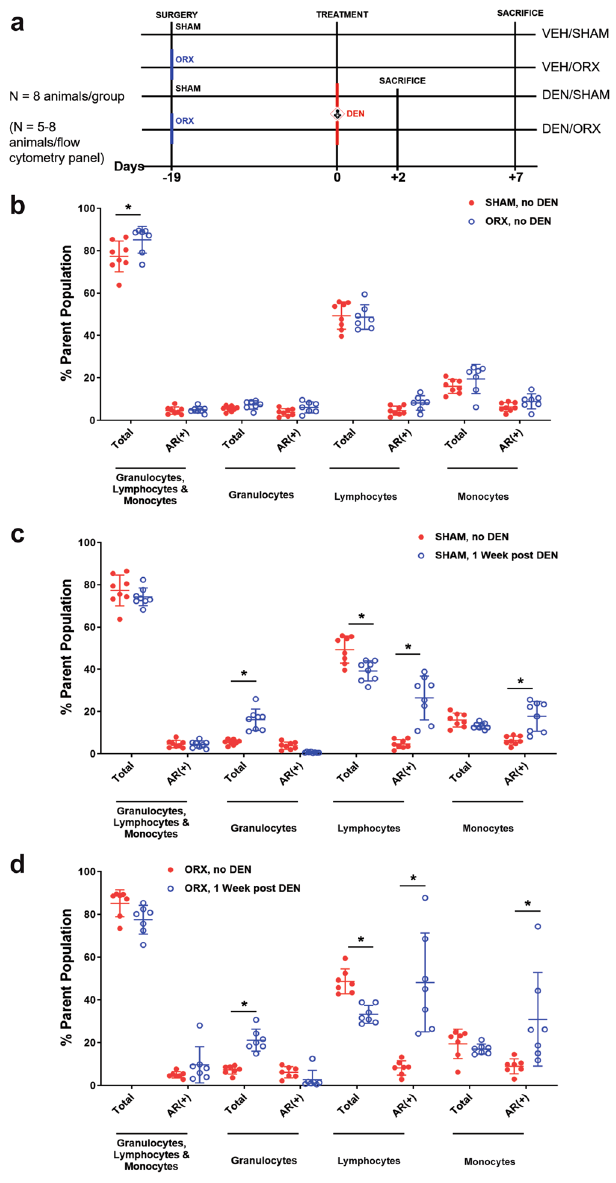
Figure 4. DEN increases proportion of AR+ lymphocytes and monocytes in SHAM and ORX. Liver immune cell populations were analyzed by flow cytometry as described in Materials and Methods and represented as percent of parent population and pre-gated on CD45+ and living cells. Positive cells were defined by fluorescence minus one (FMO) controls (See Supplementary Fig. S4 online for gating strategy). ( a ) Simplified experimental timeline. Surgery was performed on 8 mice per group 19 days prior to treatment with IP VEH or DEN (50 mg/kg). DEN mice were sacrificed at 2 and 7 days following treatment, and VEH mice were sacrificed at 7 days following treatment. ( b ) ORX increased the percentage of total CD45+ cells (* p < 0.05, Sidak’s multiple comparisons). ( c ) DEN challenge in SHAM mice increased the proportions of granulocytes, AR+ lymphocytes and monocytes and decreased that of lymphocytes at 1 week after DEN challenge (* p < 0.05, Sidak’s multiple comparisons). ( d ) The changes in ORX mice were similar to those in SHAM mice in response to DEN challenge (* p < 0.05, Sidak’s multiple comparisons). All data represented as mean ± standard